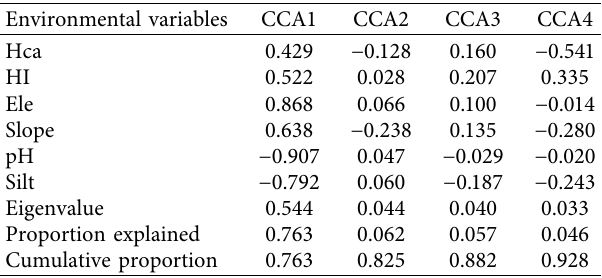
Table 11: Scores of constraining variables and correlations between environmental and disturbance factors with CCA axes in MFBR.